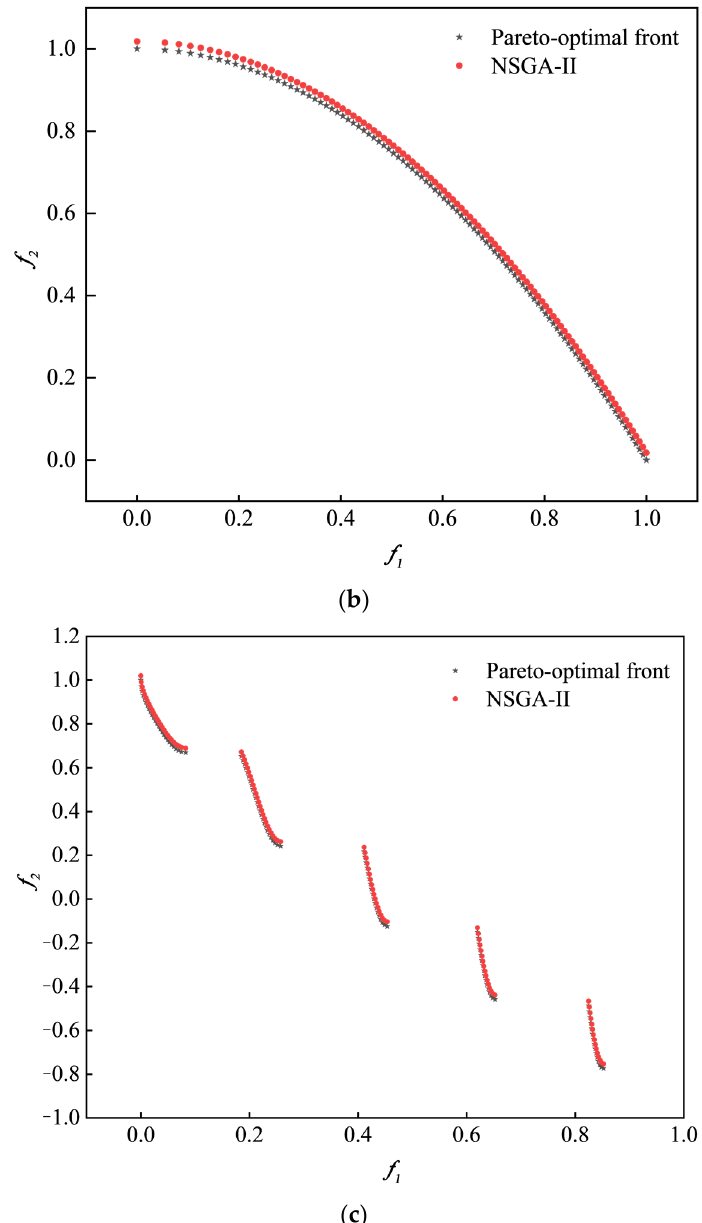
Figure 5. Test function comparison diagram. ( a ) ZDT1; ( b ) ZDT2; ( c ) ZDT3.